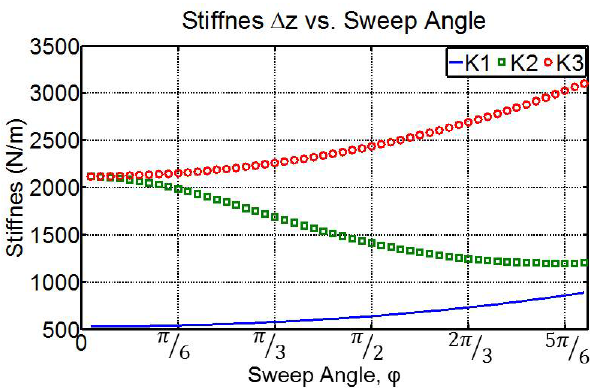
Figure 6. ∆ z -sti ff ness vs. sweep angle, φ , for three constraint con- ditions. K 1 corresponds to a cantilever beam, K 2 represents a fixed end-slope constrained beam, and K 3 corresponds to a fixed end- slope and twist constrained beam. Flexure length is held constant by varying the radius of curvature.